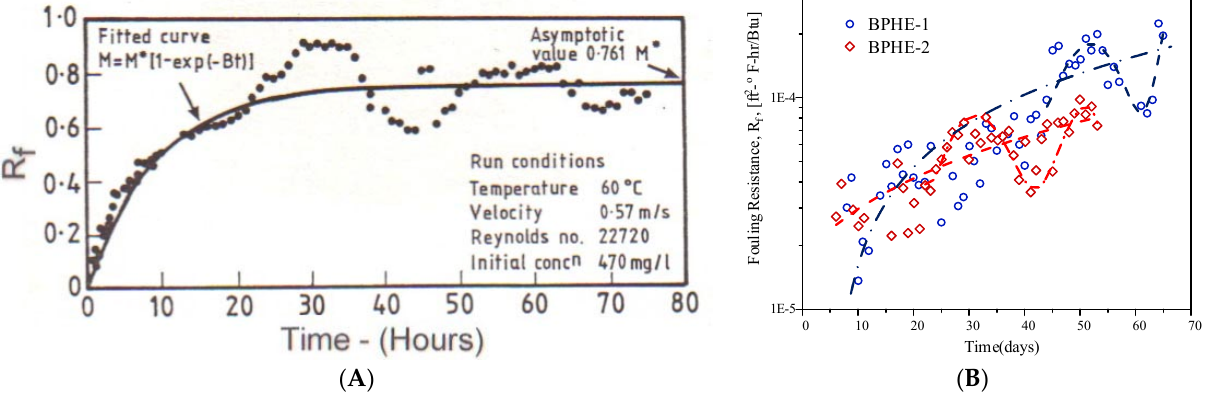
Figure 12. Sinusoidal behavior of a fouling deposit: ( A ) magnetite particulate deposition [22]; ( B ) cooling tower water fouling deposit in brazed-plate heat exchanger condenser